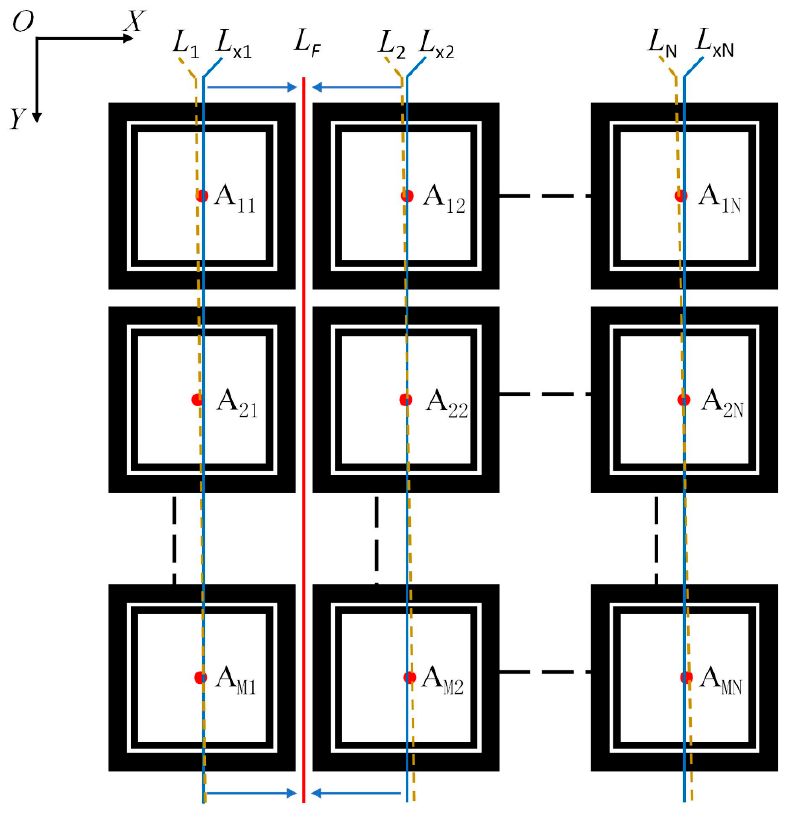
Figure 2. Definition of cutting path on the ideal wafer image.